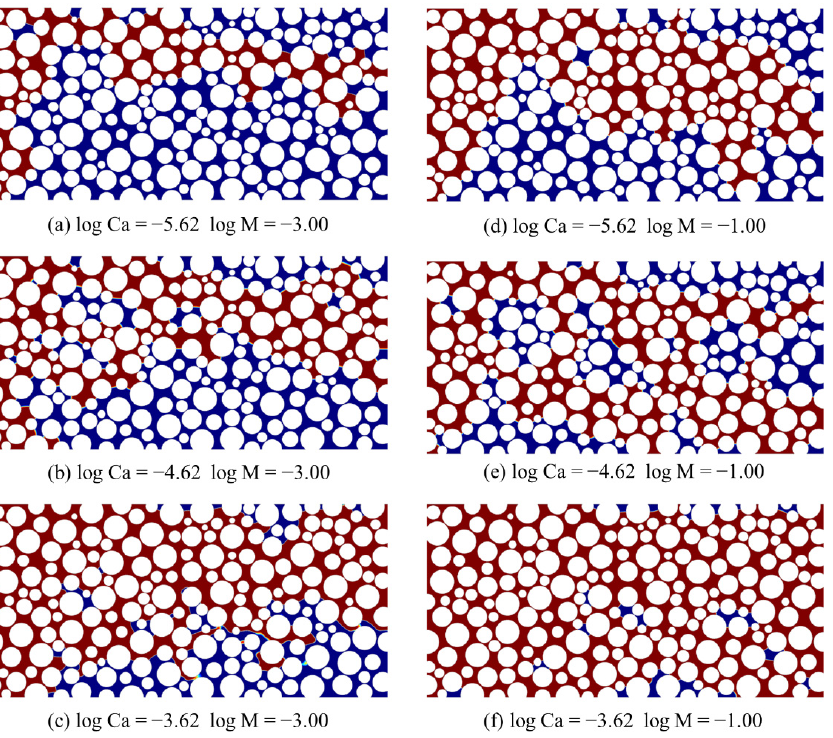
Figure 4. CO 2 saturation distribution during CO 2 breakthrough for different capillary number and viscosity ratio (red and blue regions represent CO 2 and oil, respectively).